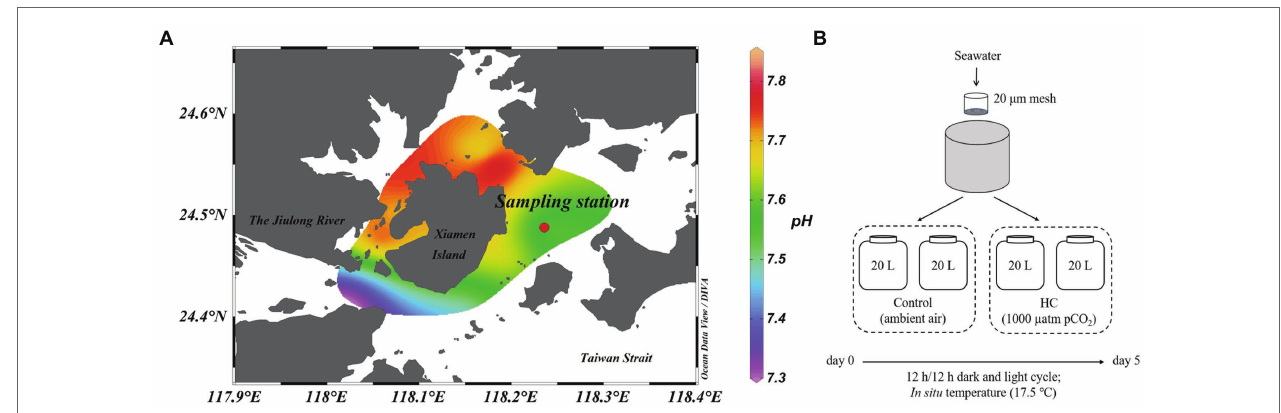
FIGURE 1 | Location of sampling station (A) and setup of microcosm experiment (B) . The mesocosms were treated with two levels of p CO 2 , HC (about 1,000 μ atm) and control (about 380–410 μ atm), and incubated under dark (0 μ E m − 2 s − 1 ) and light (64.4 μ E m − 2 s − 1 ) cycles at approximately in situ temperature (about 17.5 ° C). Map is colored according to the pH values of seawater around Xiamen Island. Map was constructed using Ocean Data View software (version